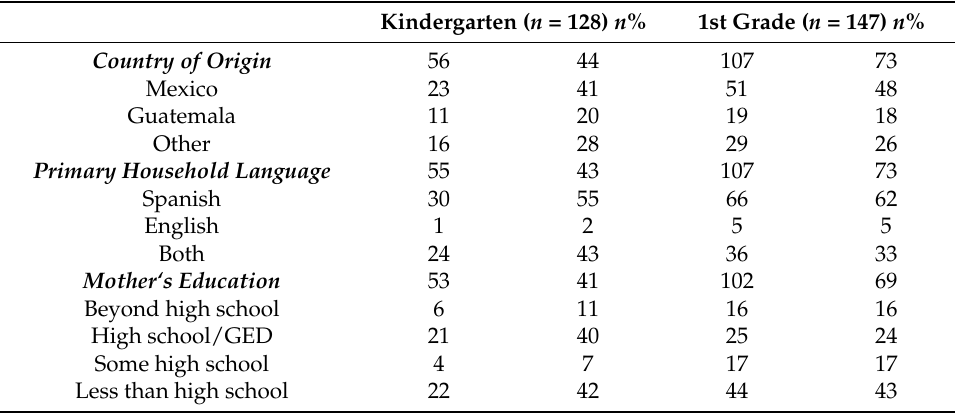
Table 3. Characteristics of participant